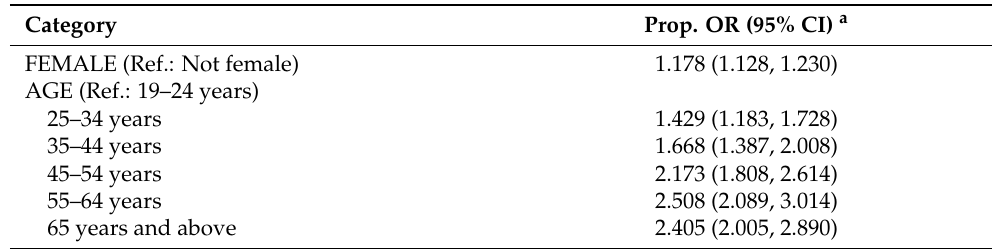
Table 2. Multivariate ordinal logistic regression of total FDA-recognized benefits of dietary fiber on demographic characteristics in the IRi survey ( n = 42,018).